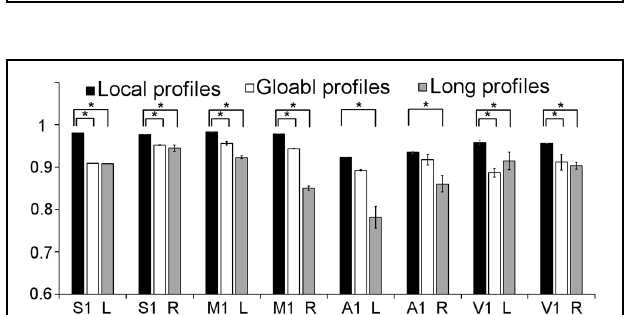
FIGURE 7 | The primary visual cortex (V1) in the left hemisphere was parcellated into two subregions using local, global, and long connectivity profiles. The MPM from dataset 1 of the V1 (first column) and four individual example results using local, global and long connectivity profiles are shown.